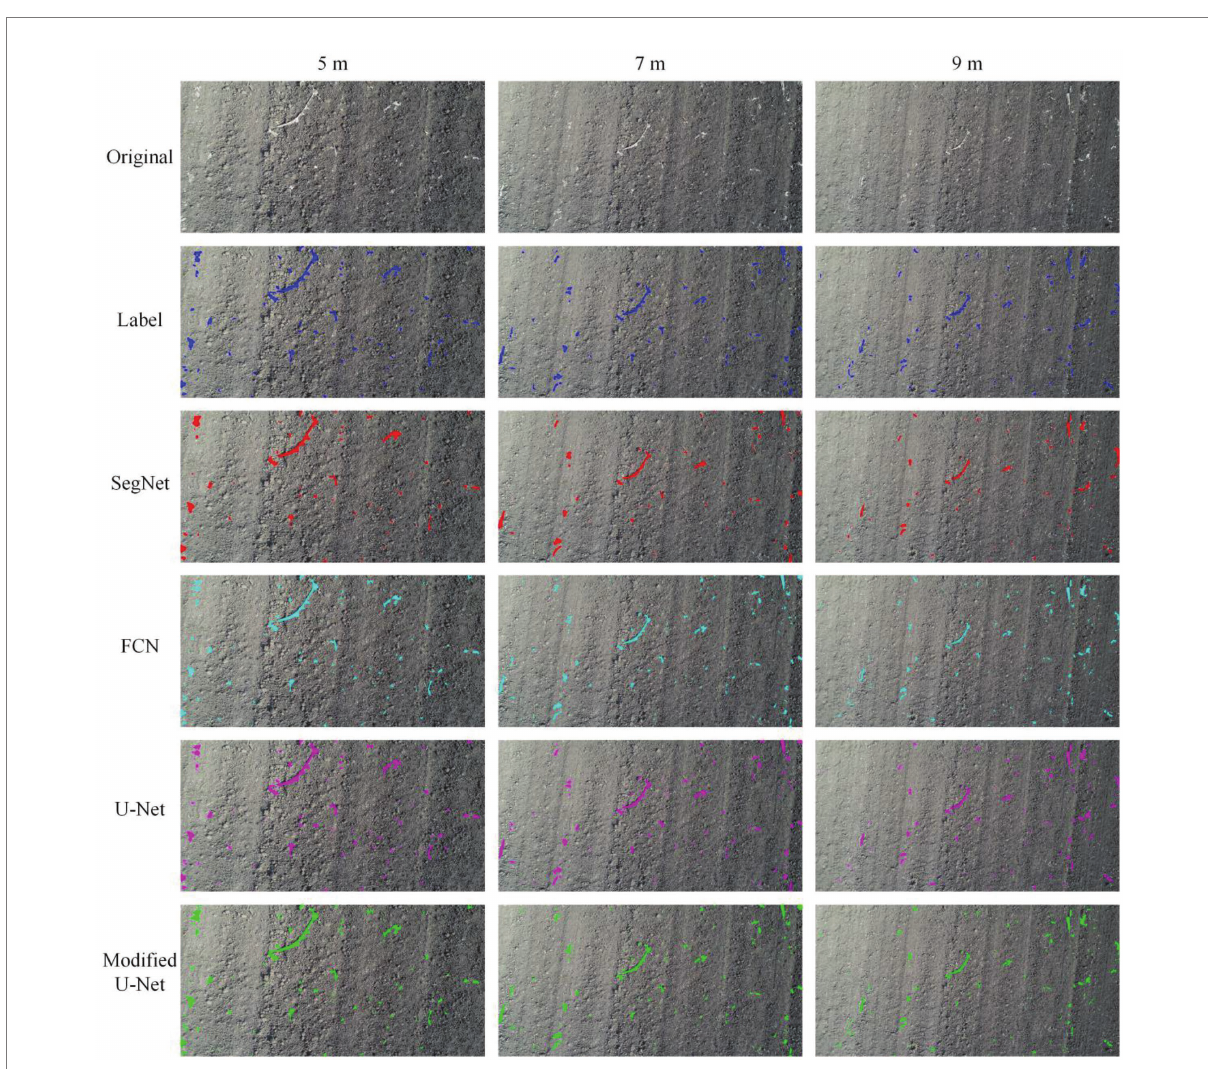
FIGURE 8 Residual film segmentation results of images acquired at different heights.